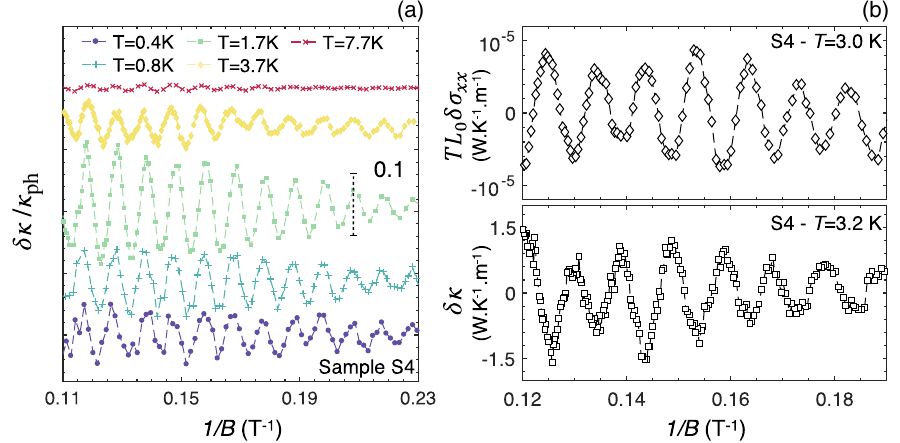
FIG. 4. Quantum oscillations of lattice thermal conductivity. (a) The oscillatory component of the thermal conductivity δκ is shown (normalized as δκ = κ ) for sample S4 as a function of 1 =B for various temperatures. Graphs are shifted vertically for clarity. The scale ph bar corresponds to a relative amplitude of 10%. (b) Comparison of the oscillations observed in the thermal conductivity δκ and in the electrical conductivity (multiplied by the Sommerfeld value and temperature). Note the 5 orders of magnitude difference in amplitude of oscillations in TL 0 σ xx and in κ ph